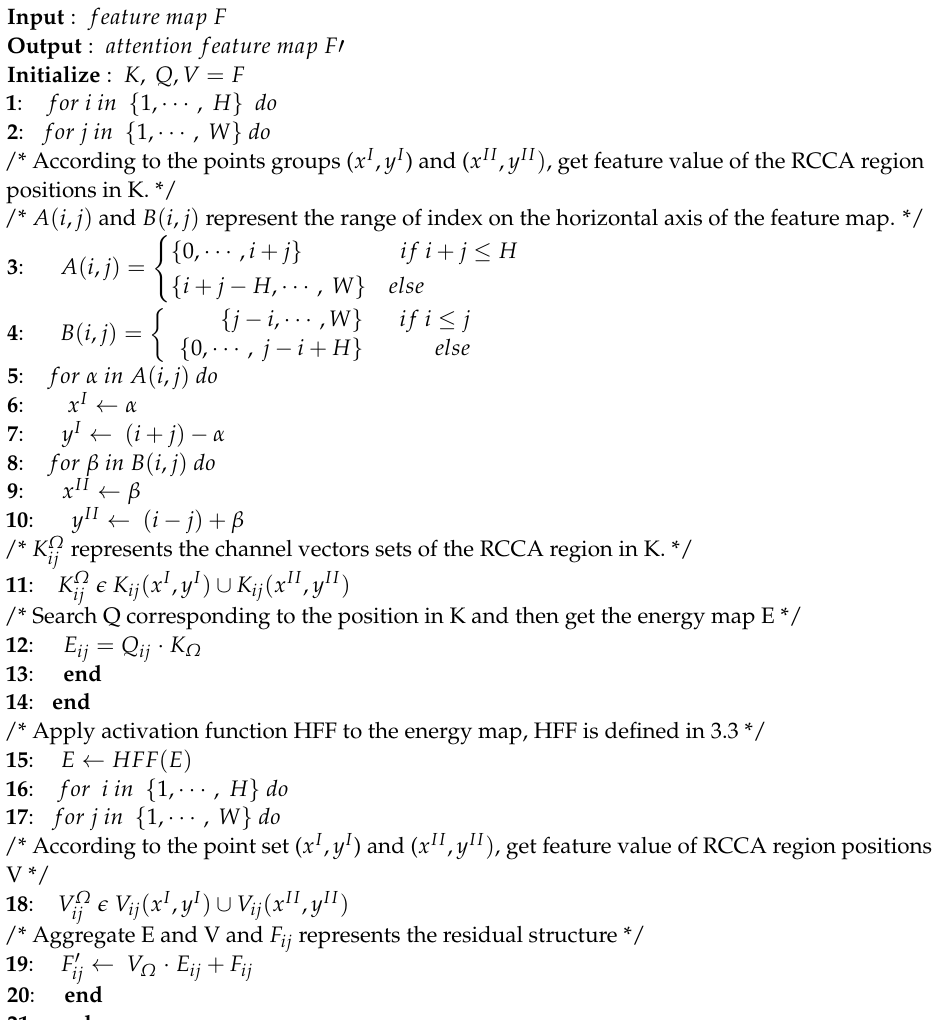
Algorithm 1. The process of RCCA attention.